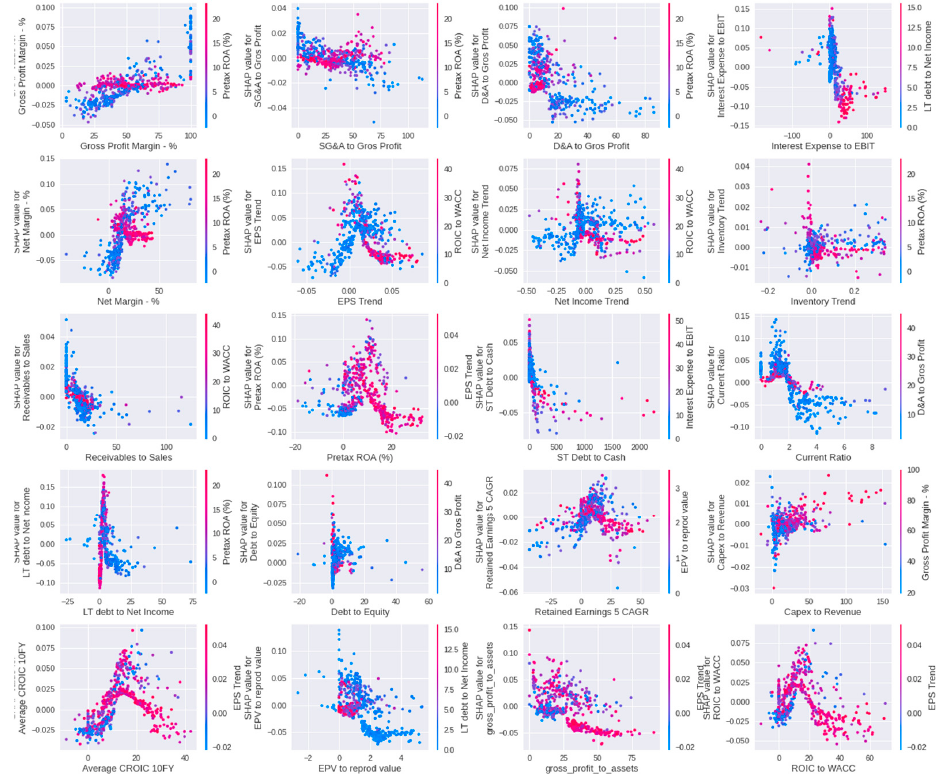
Figure A2. Dependence plot of companies with a narrow moat.